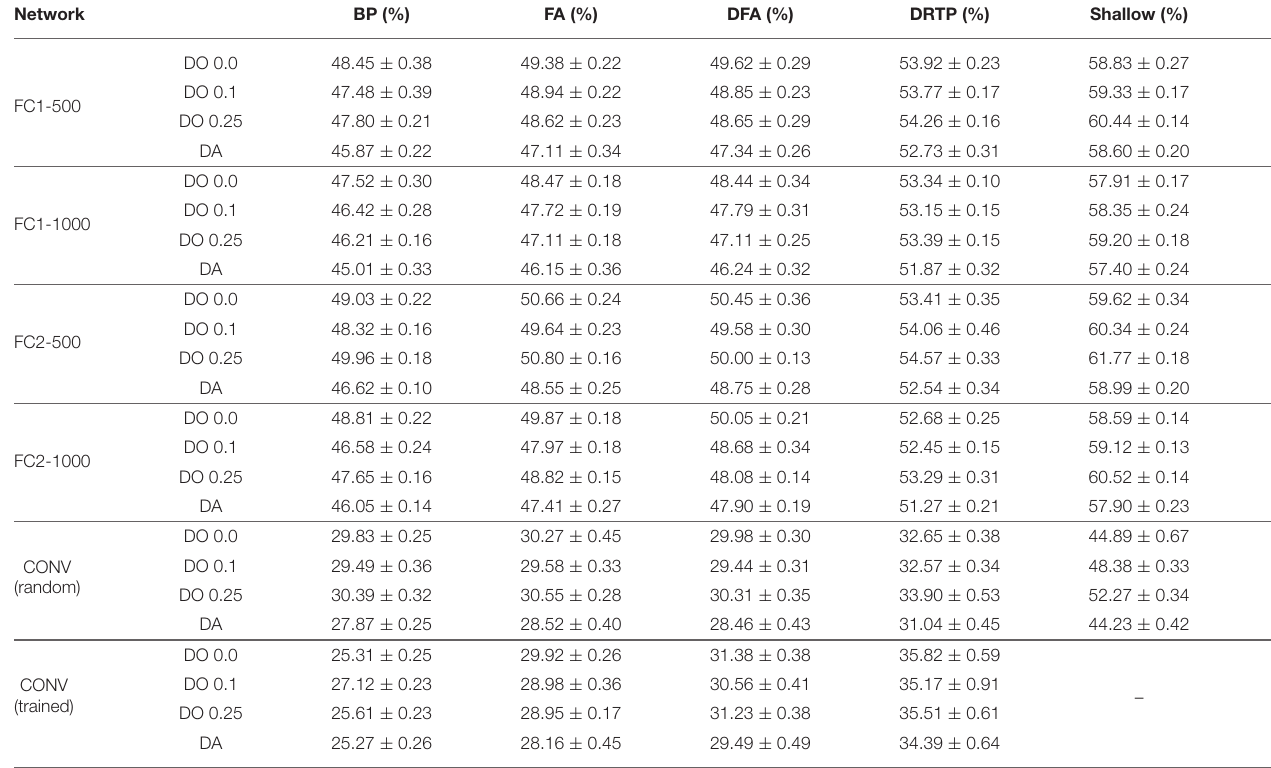
TABLE 2 | Mean and standard deviation of the test error on the CIFAR-10 dataset over 10 trials.